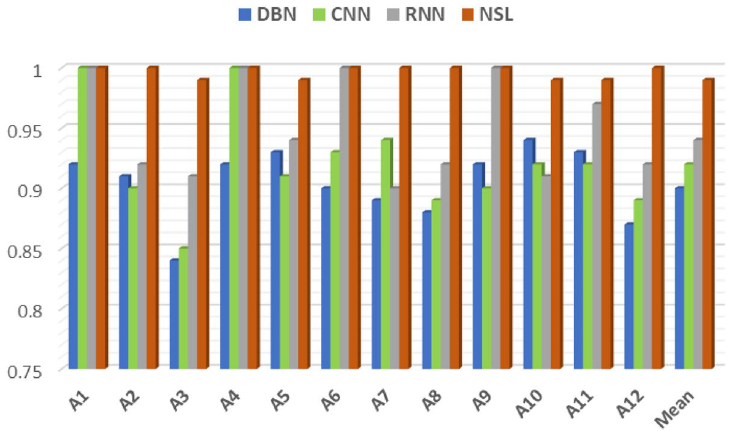
Figure 10. Mean of the recalls of the activities using four different approaches.